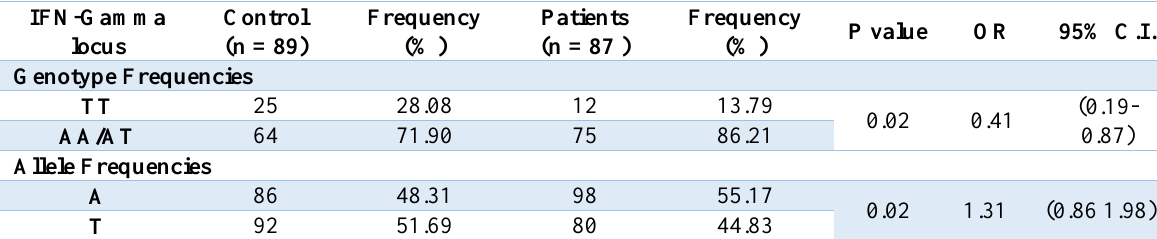
Table 2. Distribution of genotypes and allele frequencies of Interferon-gamma (+874) T/A single nucleotide polymorphism among control and patients groups.